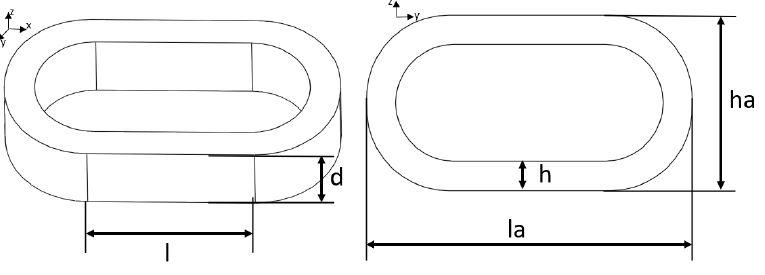
Figure 2. Schematic diagram of basic dimensions of the MHD linear vibration sensor fluid channel.